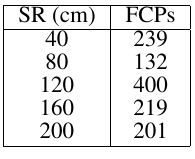
Table 2. Number of FCPs at different